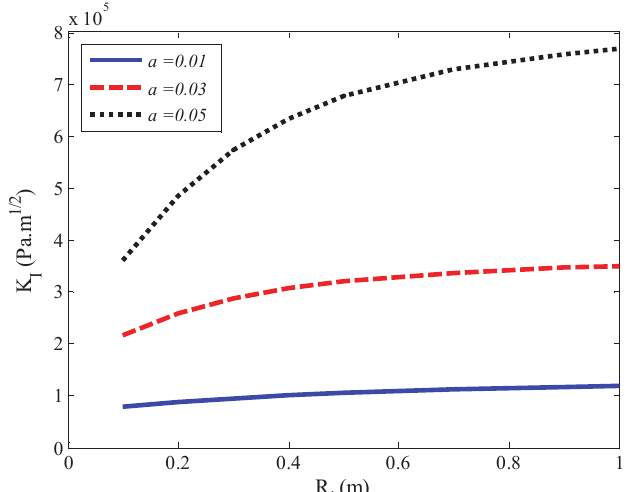
Figure 11: Plots of SIF vs. inner radius of hollow cylinder under uniform axial tension for P 0.2 (cid:32)